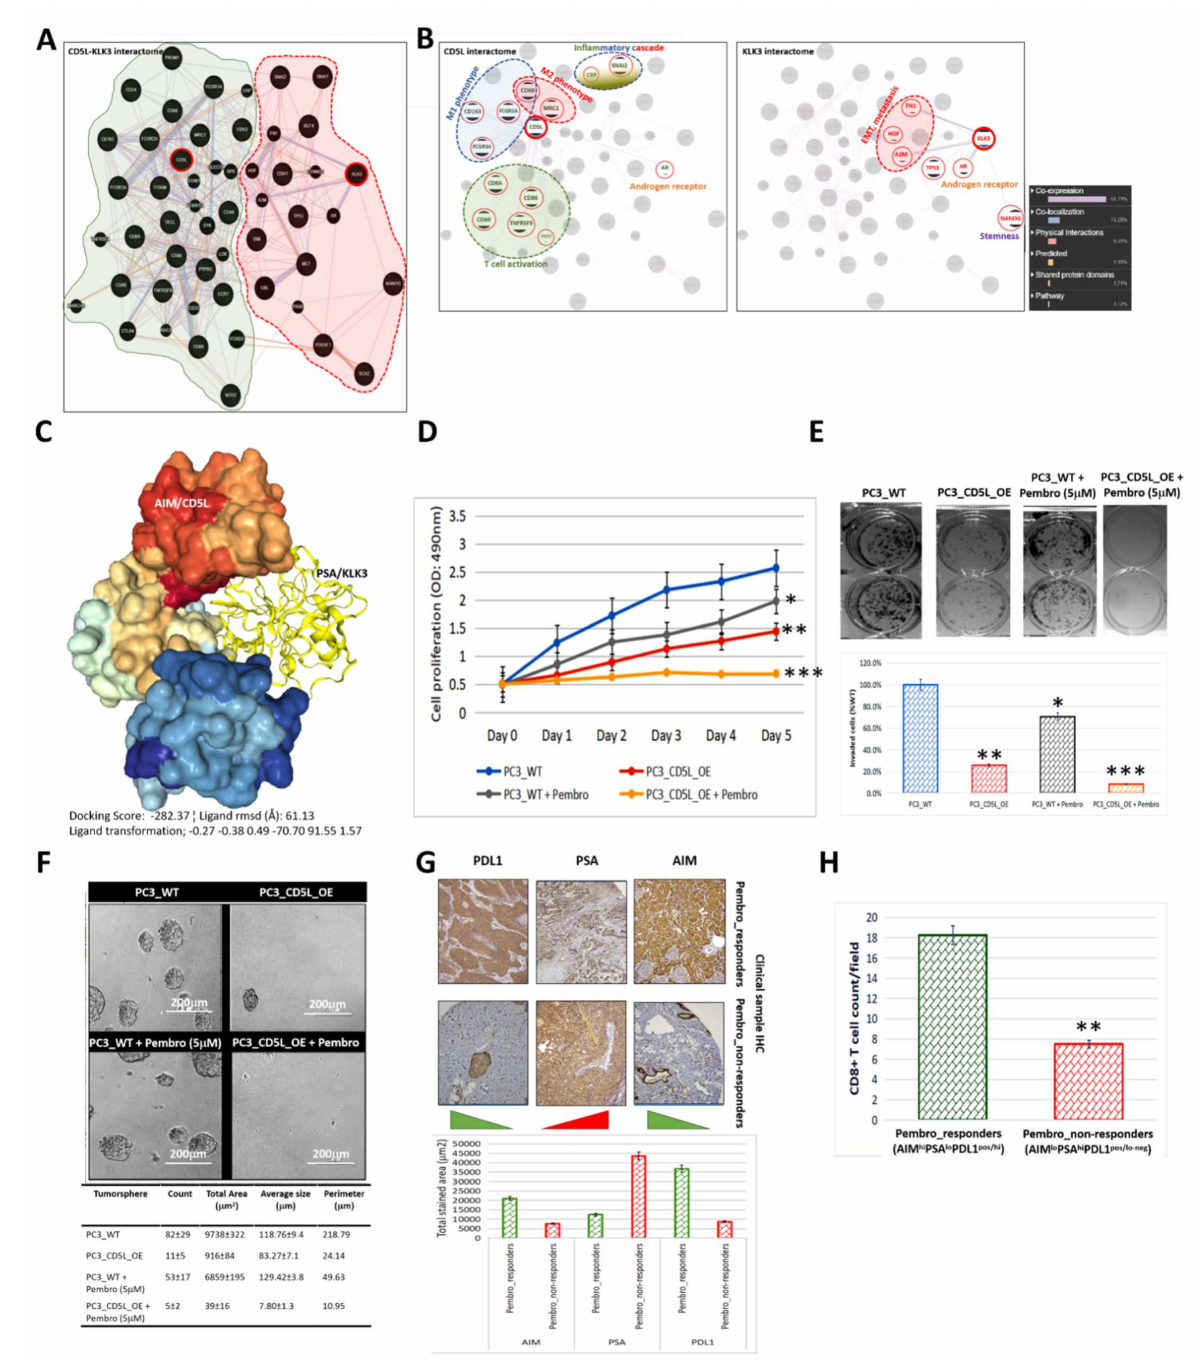
Figure 7. AIM binds directly to PSA, and the ectopic (re)expression of AIM enhances the anticancer therapeutic effect of Pembrolizumab against PCa cells. 2D visualization of the auto-generated ( A ) CD5L-KLK3 interactome showing com- plicity in the immune landscape, macrophages, EMT and CSC regulation, ( B ) CD5L interactome, or KLK3 interactome. ( C ) Three-dimensional visualization of the direct complex formation by AIM/CD5L (surface model) and PSA/KLK3 (ribbon model). ( D ) Line graph showing the effect of CD5L_OE with or without 5 µ M Pembrolizumab on PC3 cell proliferation. ( E ) Representative photomicrographs ( upper ) and histograms ( lower ) showing the effect of CD5L_OE with or without 5 µ M Pembrolizumab on PC3 cell invasion. ( F ) Representative photomicrographs ( upper ) and quantitative chart ( lower ) showing the effect of CD5L_OE with or without 5 µ M Pembrolizumab on the tumorsphere formation capability of PC3 cells. ( G ) Representative IHC photomicrographs ( upper ) and histograms ( lower ) of the immunoreactivity of AIM, PSA, and PDL1 in pembro_responders or pembro_non-responders from the TMU-SHH cohort. ( H ) Histograms showing the differential CD8 + T-cell count/field in pembro_responders or pembro_non-responders from the TMU-SHH cohort. WT, wild type; OE, overexpression; * p < 0.05; ** p < 0.01; *** p <